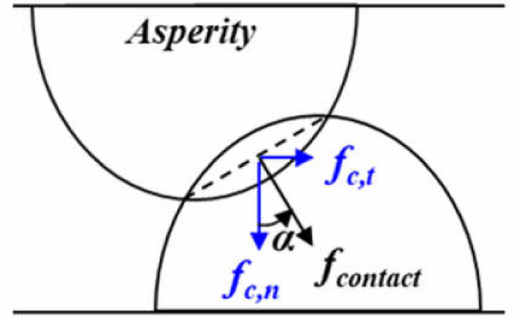
Figure 2. Contact force between two